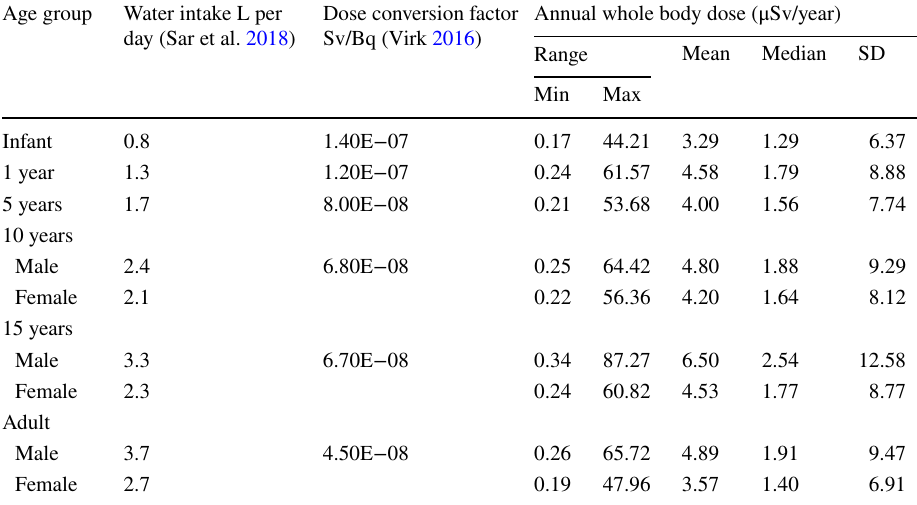
Table 6 Statistical parameters— annual whole body